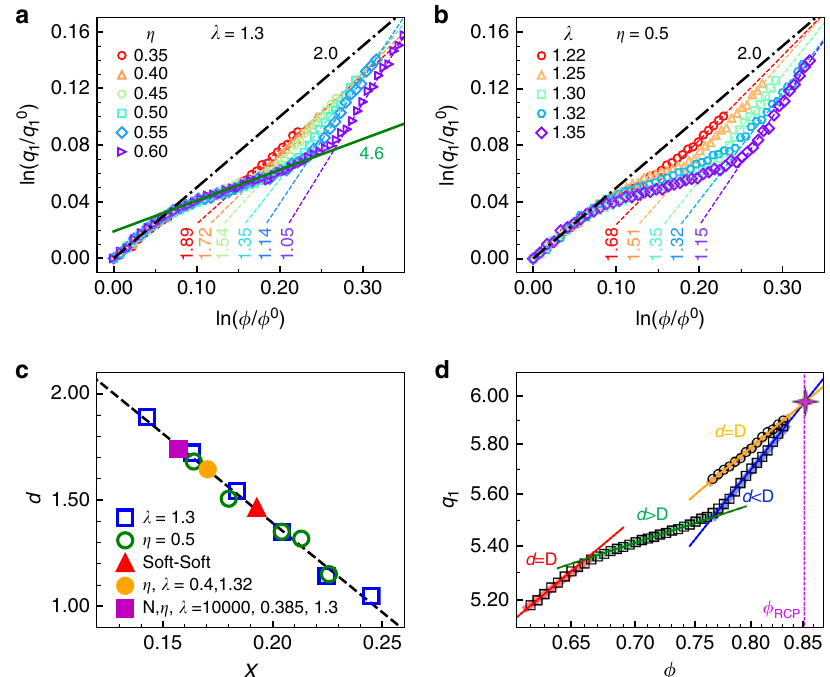
Fig. 3 Effect of deformable part on the FPLs in 2DSH glasses. a FPLs for systems with different values of η at the fi xed λ = 1.3. The fi tted exponent 1.05 ≤ d ≤ 1.89 in the glass regime and remains a constant d = 4.6 in the crossover regime. b FPLs for systems with different values of λ at the fi xed η = 0.5. c All d ’ s fi tted from a and b collapse into a linear function of the area fraction of soft shells, X . We further measured three other systems and all of their d ’ s lie on this line, including the 2DSH system with ( η , λ ) = (0.4, 1.32) (orange circles), a smaller system with ( N , η , λ ) = (10000, 0.385, 1.3) (purple squares) and a soft/soft mixture with ( σ 1 , λ 1 , σ 2 , λ 2 ) = (1,1.28,1.24,1.03) at η 1 = 0.4 (red triangles). d The extrapolations of the fi tted power laws of the 2DSH glass (blue line; Fig. 1f) and the 2DHH glass (orange line; Fig. 1b) meet at the 2D random-close-packing point: ϕ RCP ≃ 0.850 (purple star). Both systems have ( η , λ ) =